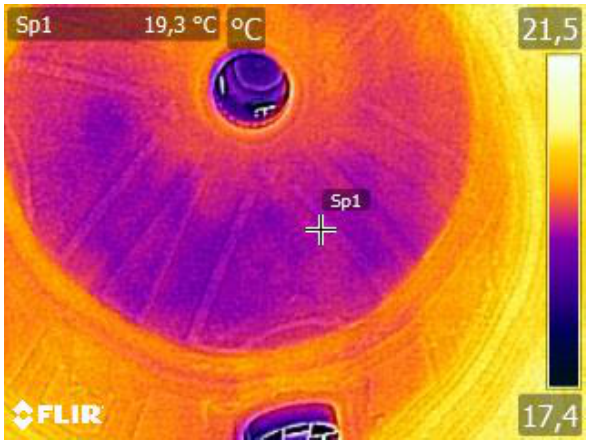
Figure 3. Thermal images visualization in FLIR